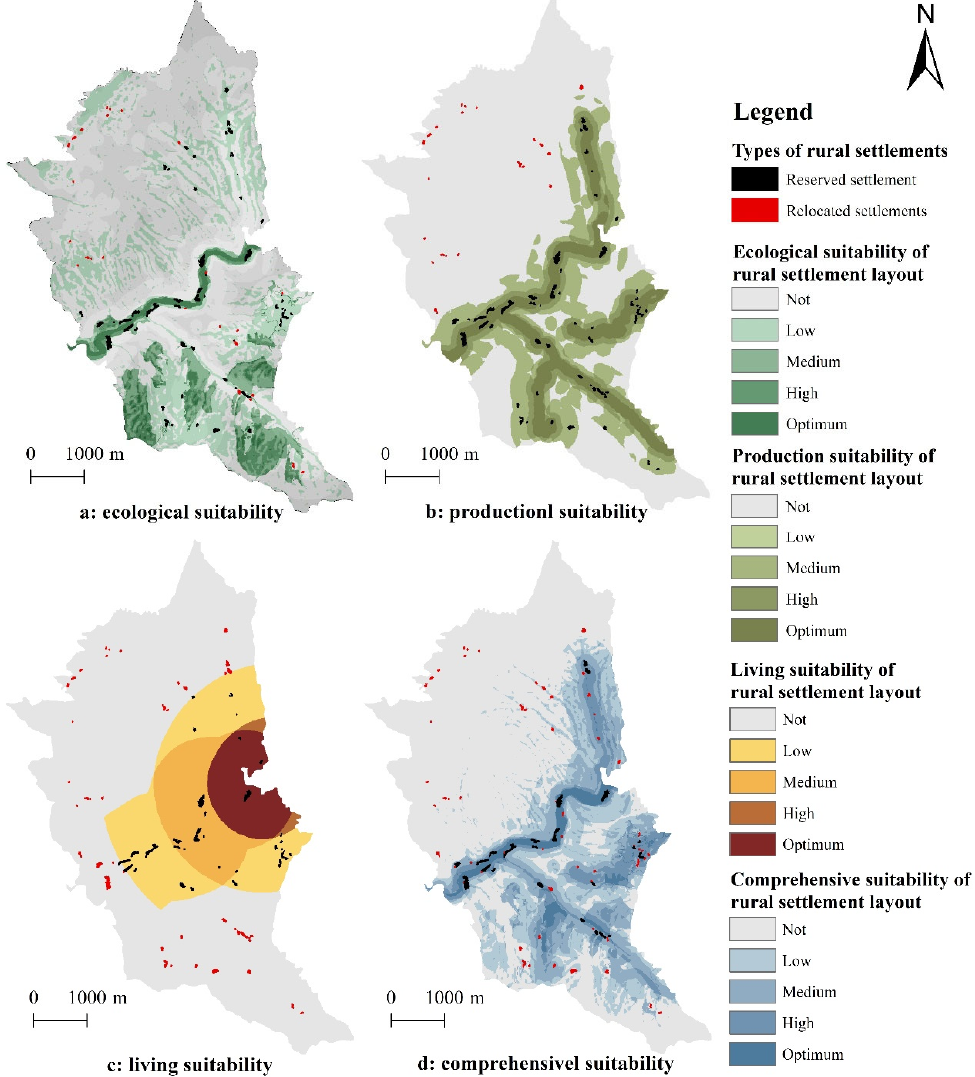
Figure 3. Suitability of rural settlement layout based on different dimensions in the village of Pingba.